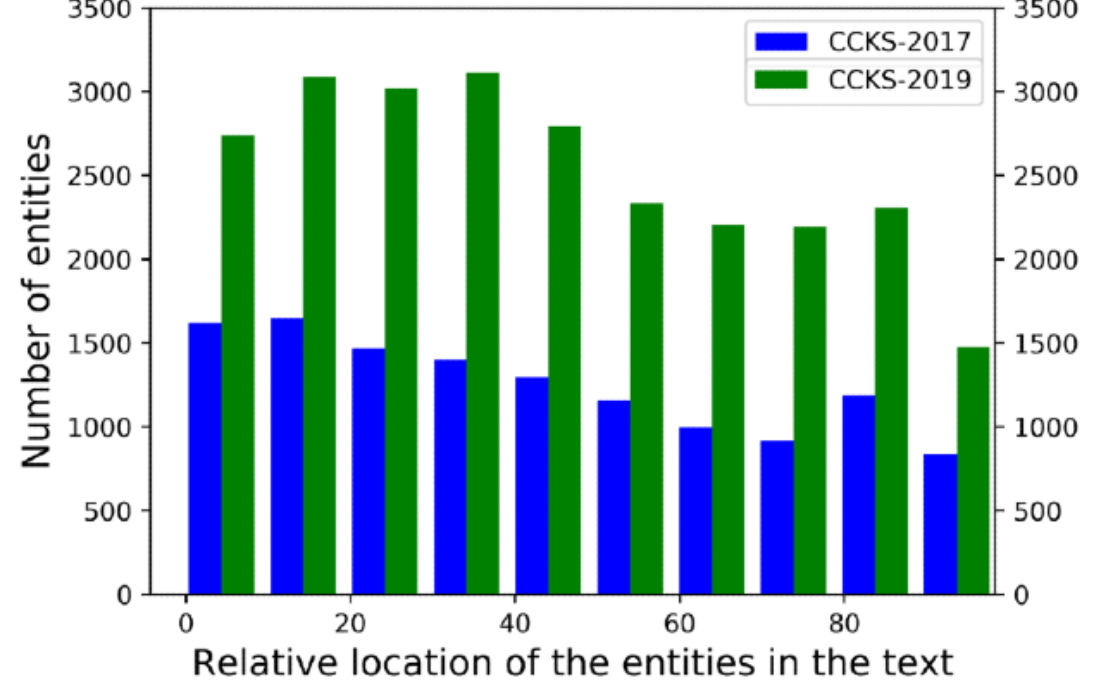
Figure 3. Distribution of relative locations of entities in two Chinese clinical named entity recognition (CNER) datasets. CCKS: China Conference on Knowledge Graph and Semantic Computing.